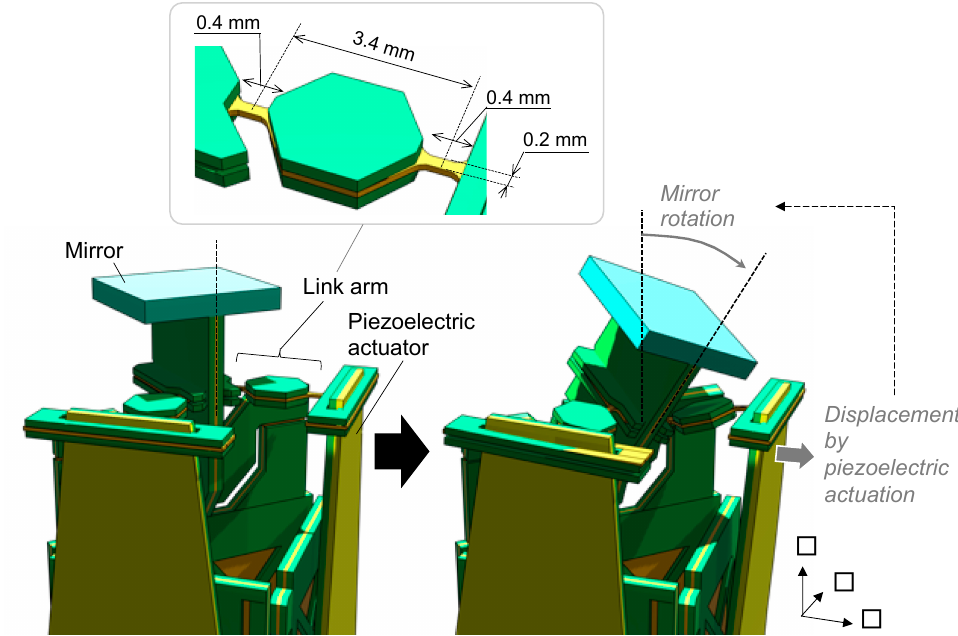
Figure 4. Actuation behavior and structure of link arm.